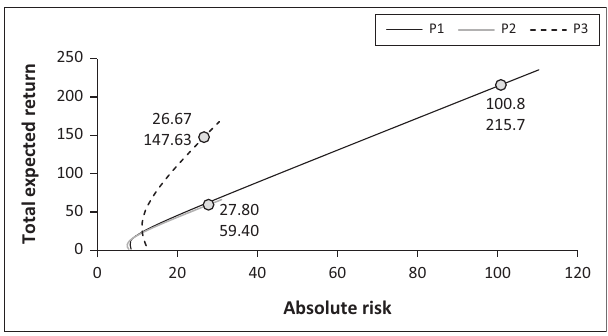
FIGURE 3: Portfolio A (precious metals) efficient frontiers during periods 1, 2 and 3.